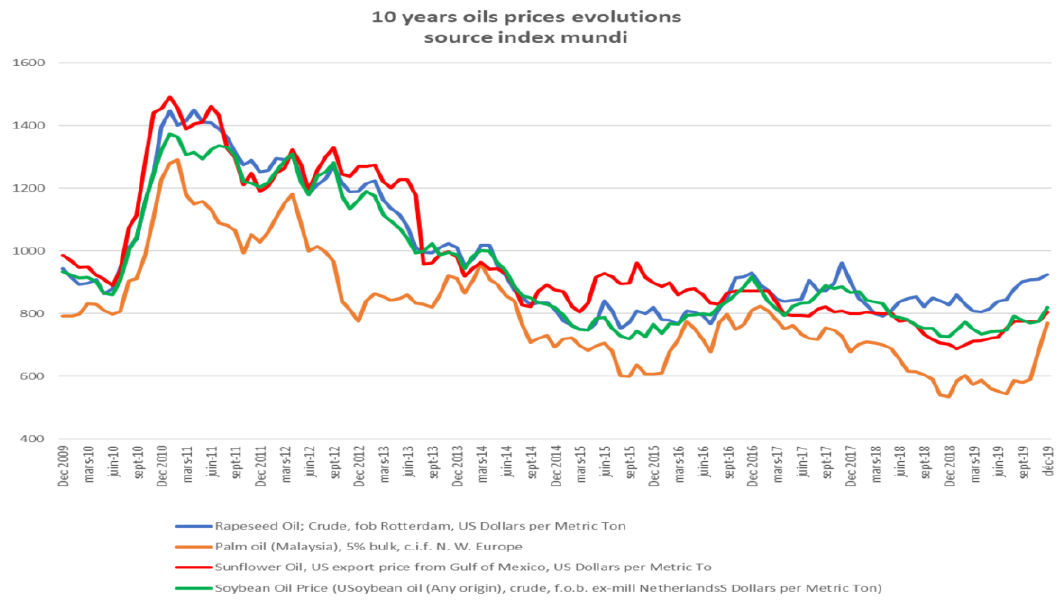
Figure 4. E volution of vegetable oil prices (2009 – 2019). (Source: Pilorgé [49]) Figure 4. Evolution of vegetable oil prices (2009–2019). (Source: Pilorg é [49]). Table 4. Total annual and mean annual embodied deforestation by the macroeconomic sector (2002–2019). Source: our elaboration based on UNCOMTRADE